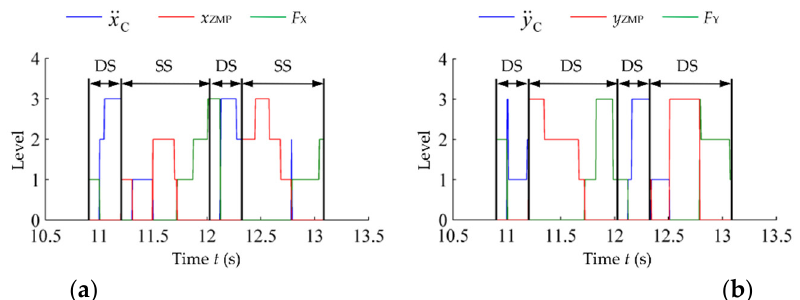
Figure 17. Action switching in random stepping. ( a ) Action switching in sagittal plane; ( b ) action switching in lateral plane.